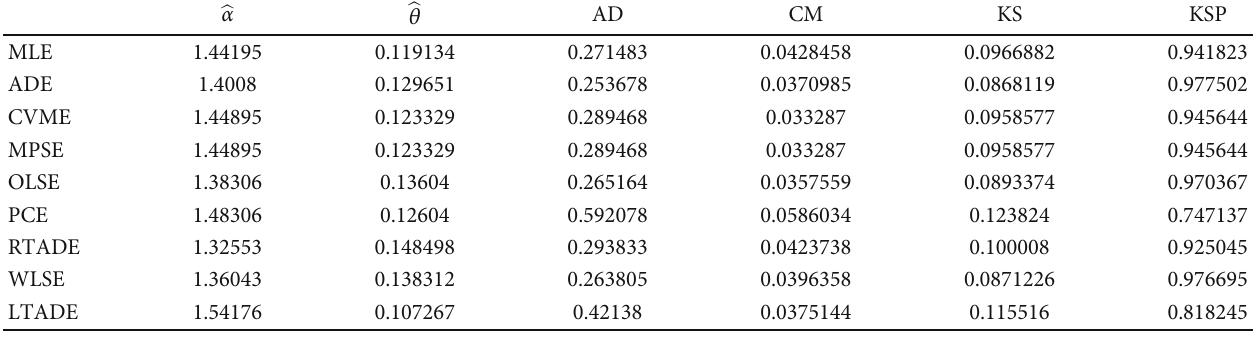
Table 9: The estimates of PXL distribution parameters and goodness-of- fi t measures by di ff erent estimation methods. b α